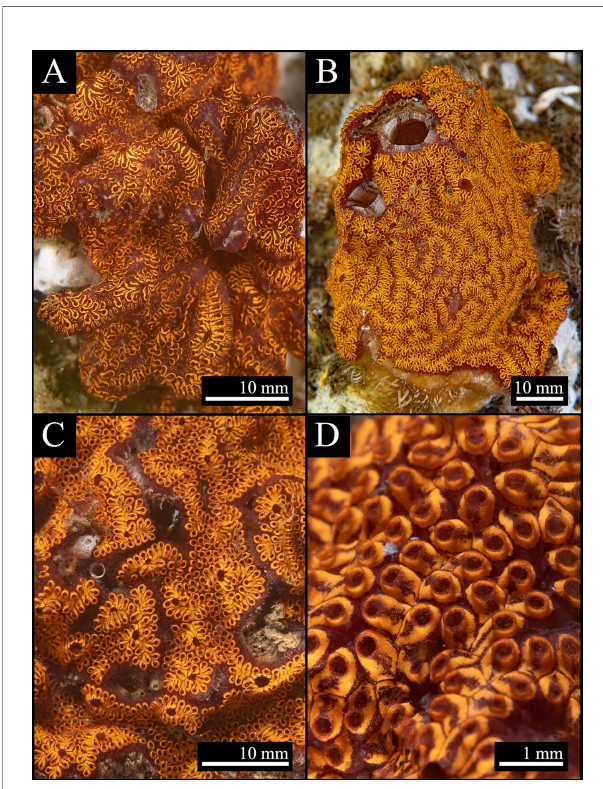
FIGURE 1 | Botrylloides niger Herdman, 1886 from the Fusaro Lake channel (Bacoli, central Tyrrhenian Sea, Mediterranan Sea). (A) Colony forming an aggregate on the dock wall. (B) Colony overgrowing a specimen of Styela plicata (Lesueur, 1823). (C) Colony growing amidst serpulids and other tunicates. (D) A close-up showing zooids placement and atrial